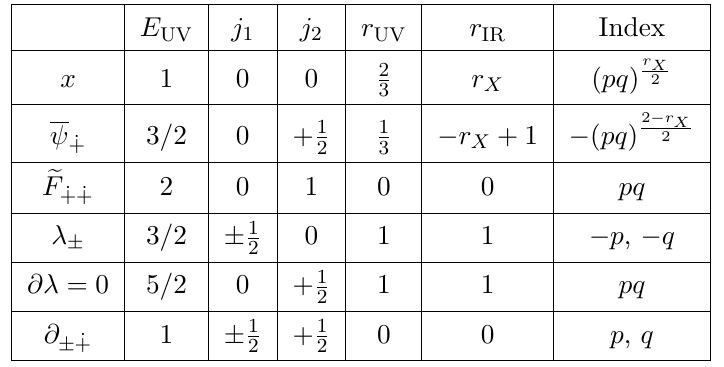
Table 18. Letters of a free chiral multiplet X = { x, ψ, F } , its conjugate X = { x, ψ, F } and